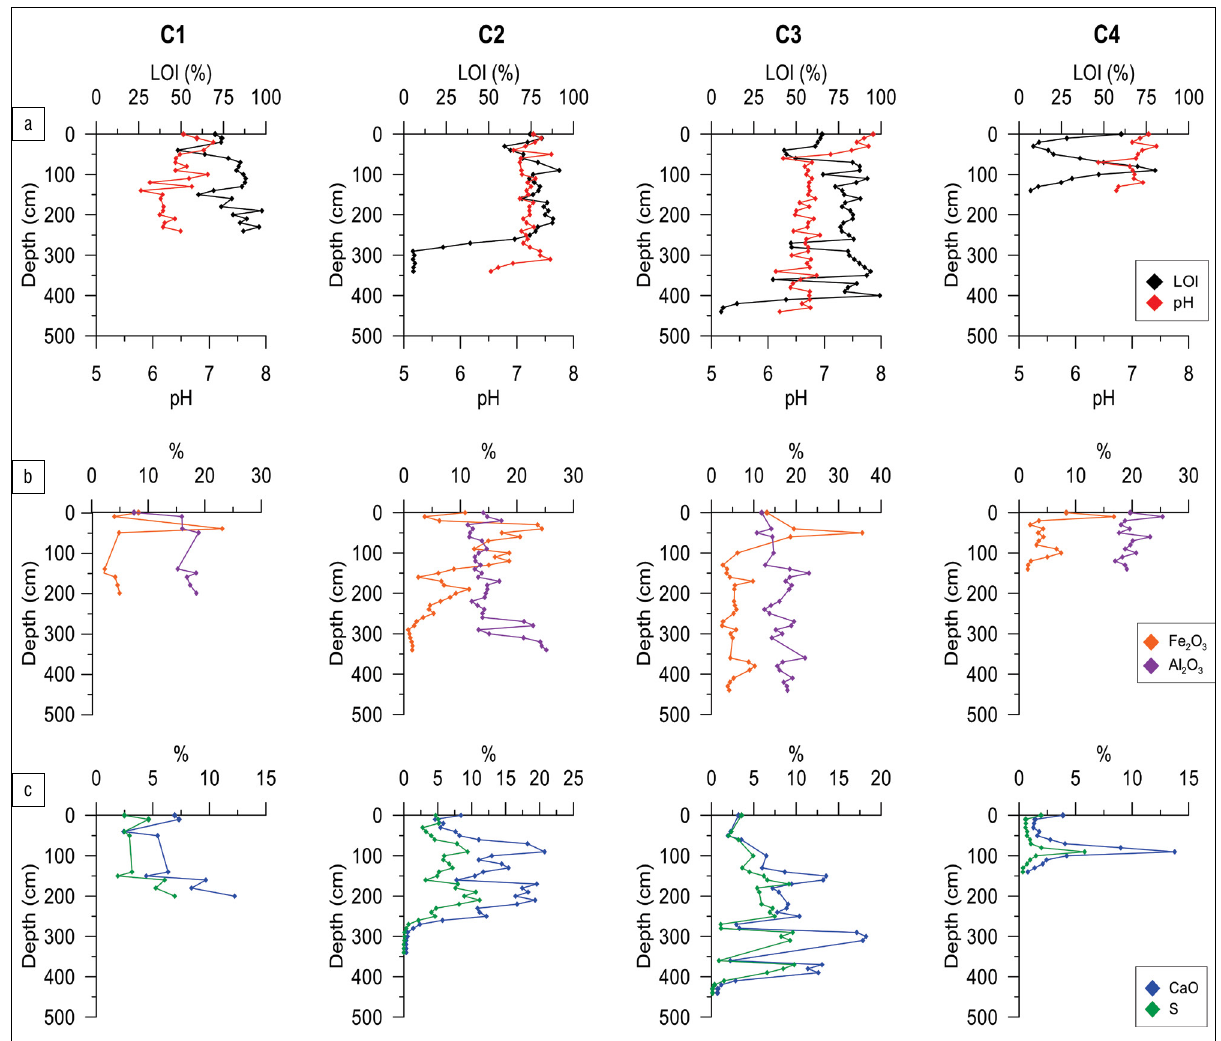
O and Al O concentrations, and (c) CaO and S 2 3 2 3